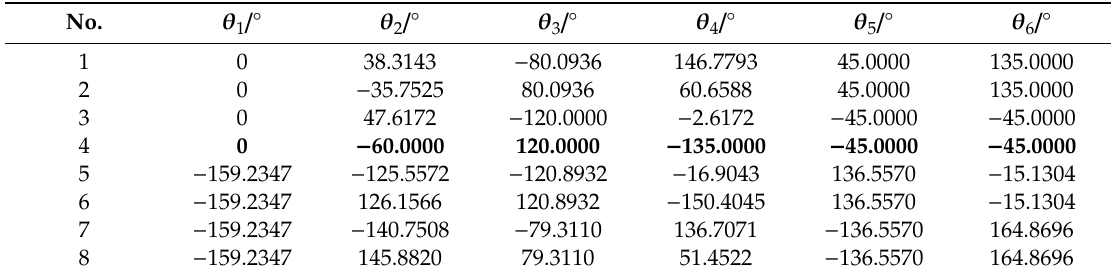
Table 19. Eight sets of reversely solved joint